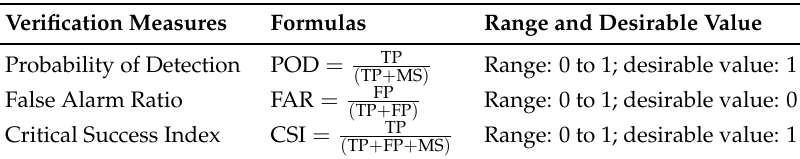
Table 3. Description of the verification metrics. TP denotes the number of true positive events, MS denotes the number of missing events, FP denotes the number of false-positive events, TN denotes the number of true-negative